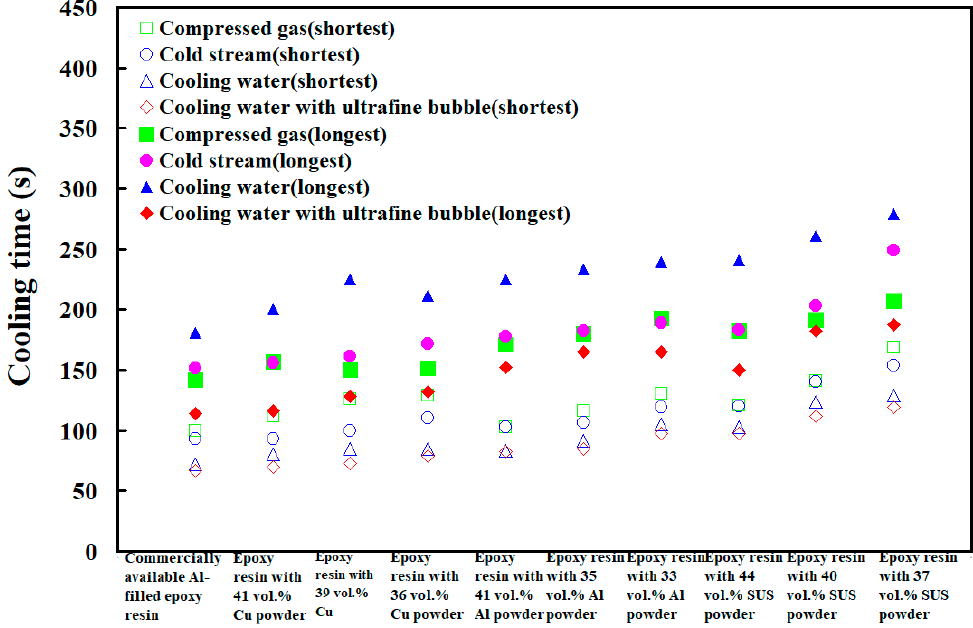
Figure 22. The longest and shortest cooling time of injection molded parts fabricated by ten sets of injection molds cooled with different four different cooling media.